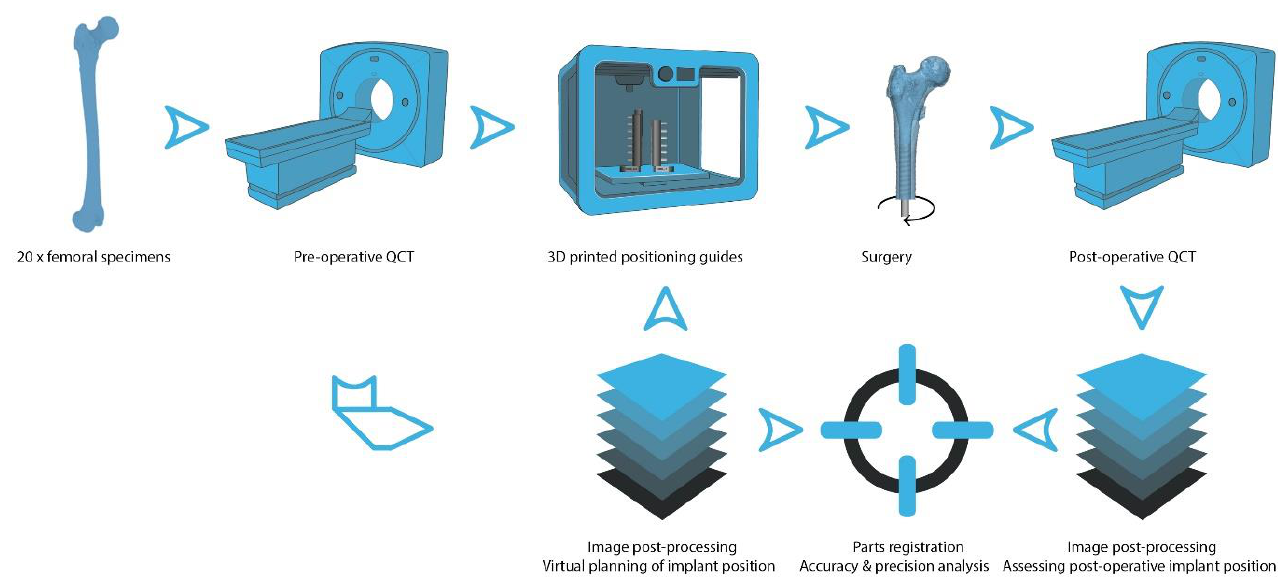
Figure 1. Graphical summary of the methodology: Twenty femoral anatomic specimens were scanned using a clinical QCT scanner. QCT images were postprocessed to create digital 3D bone models, define the optimal fixture (intramedullary component of the OPRA implant system) position and create specimen-specific positioning guides that were additively manufactured using a 3D printer. Following surgery, the specimens were QCT-scanned again and a postoperative digital 3D bone model of each specimen was created. In the last step, the 3D model pairs (pre- and postoperative) were registered and the deviation of the intraoperatively achieved implant position from the preoperatively planned implant position was analyzed. (Parts of the figure created with BioRen- der.com.)